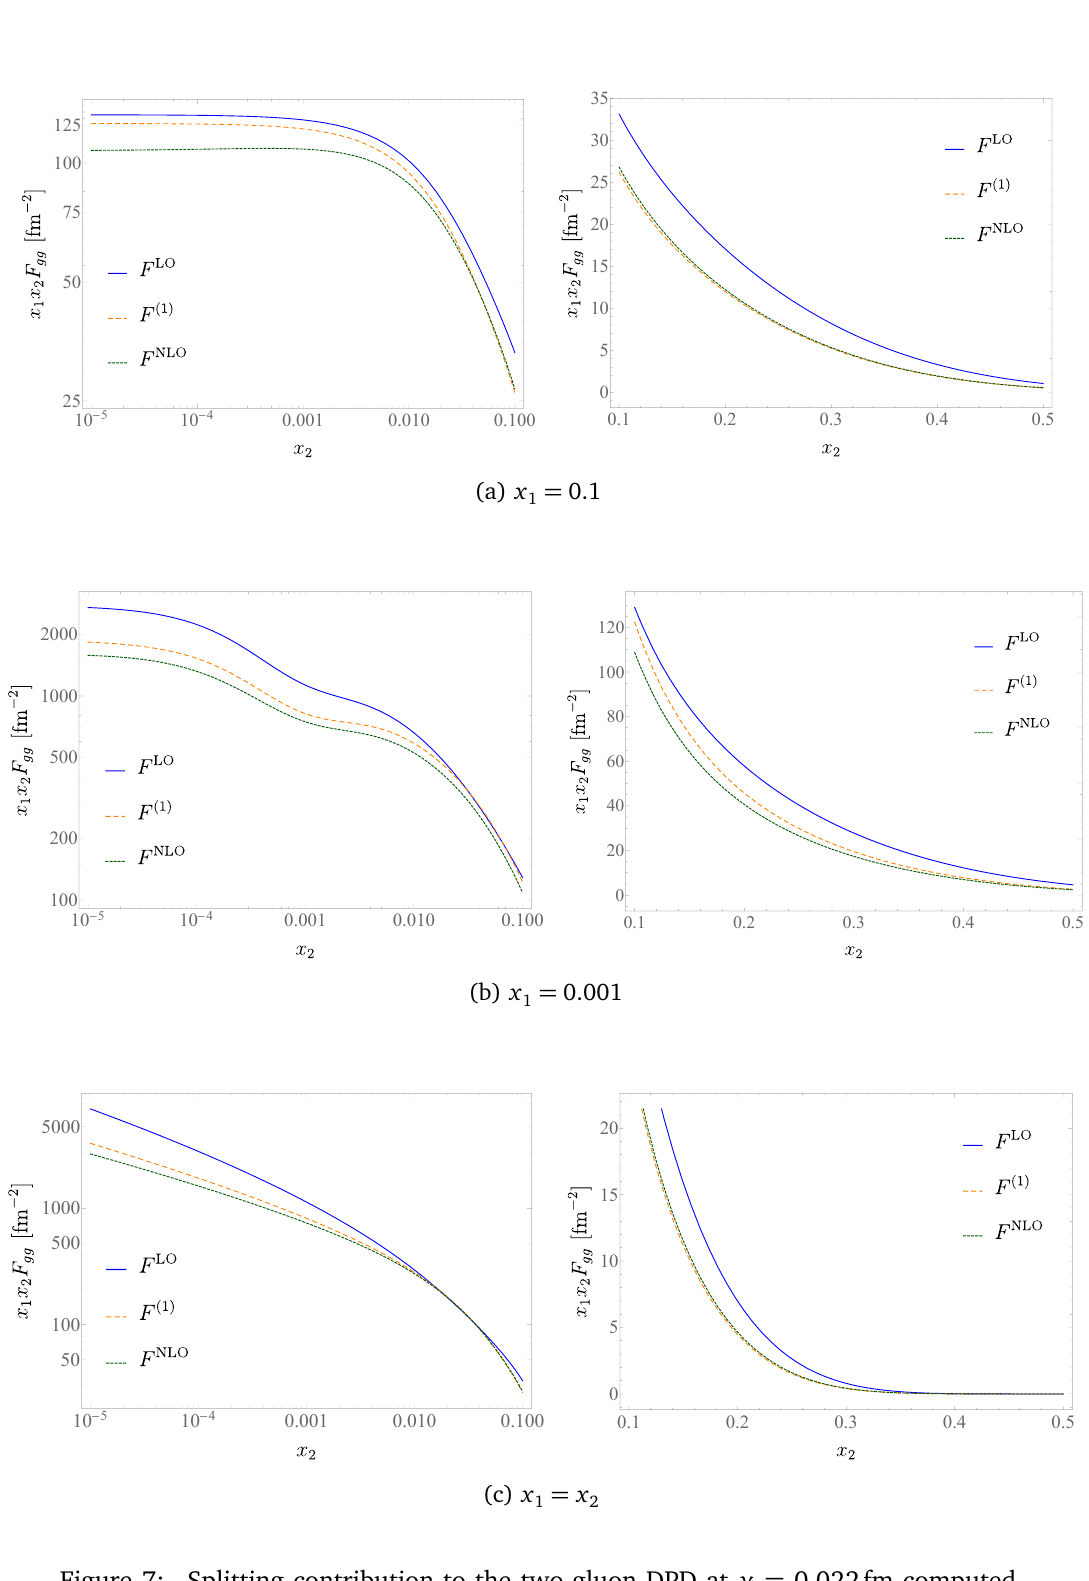
( a ) part F ( 1 ) of the NLO result. The difference s O and the PDFs at the r.h.s. of (172) are s